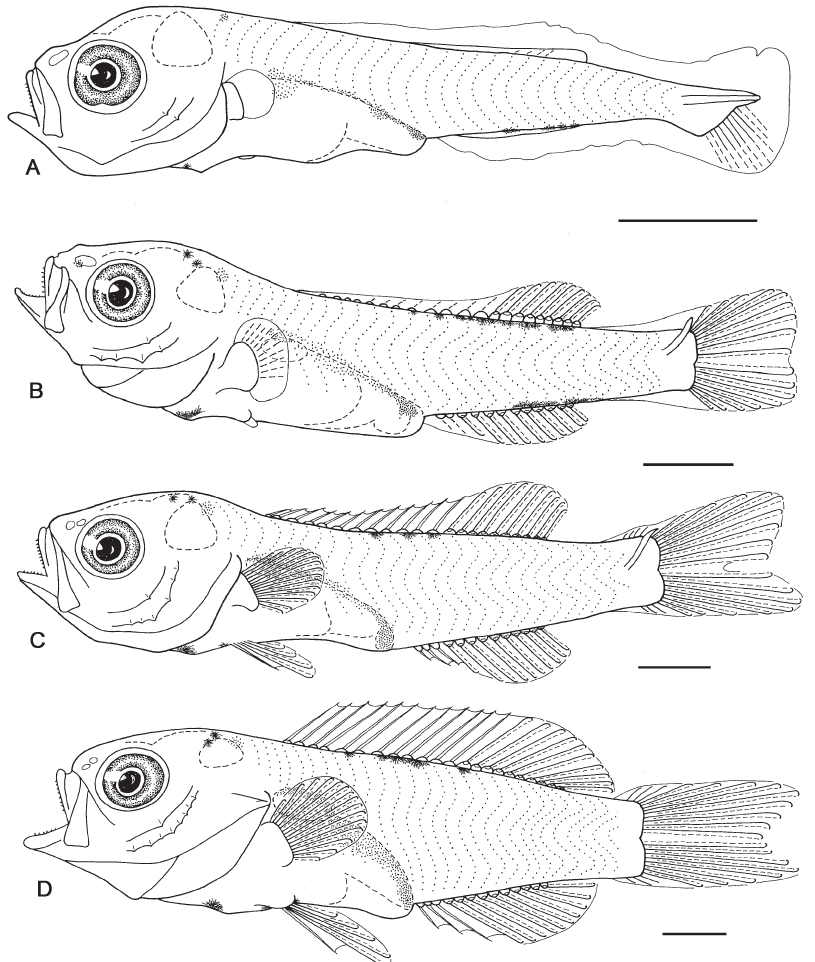
Fig . 1. – Reared larvae of Gramma loreto . A and B from cohort 2 (15 days after hatching), C and D from cohort 1 (23 days after hatching). Scale bars are 1 mm. Body lengths are post-shrinkage. A, 5.1 mm preflexion larva (AMS I.45583-001); B, 6.6 mm postflexion larva (AMS I.45583-002); C, 8.1 mm postflexion larva (AMS I.45582-001); D, 9.4 mm postflexion larva (AMS